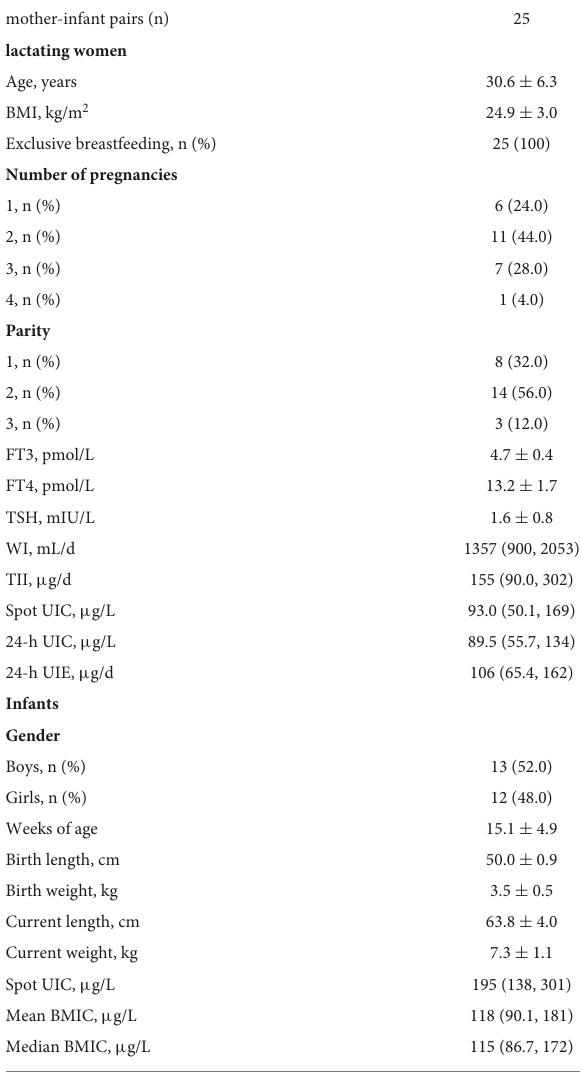
TABLE 1 Characteristics of lactating women and their